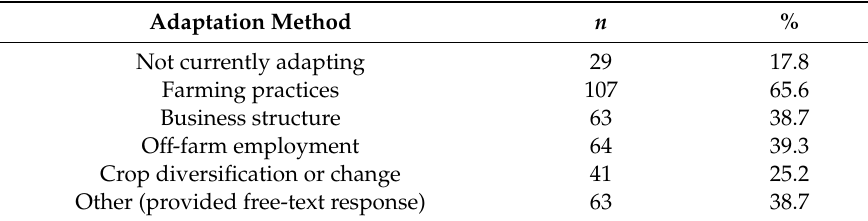
Table 4. Current climate adaptation